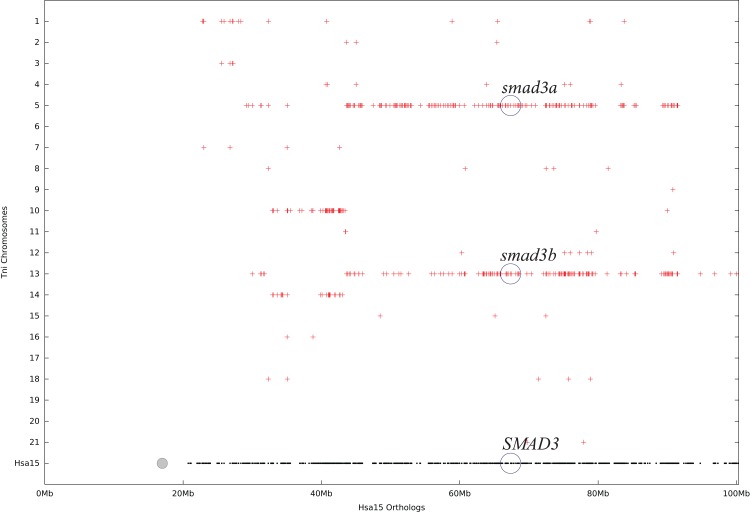
Chromosome synteny of teleost SMAD3 paralogs.The dot plot between human SMAD3 region and green spotted puffer genome indicates that human SMAD3 gene region in chromosome Hsa15 shares double conservation with green spotted puffer smad3a gene region in chromosome Tni5 and smad3b gene region in chromosome Tni13. The black dots represent segments in human chromosome Hsa15, and the red dots represent the conserved segments in green spotted puffer genome which mostly located in chromosome Tni5 and Tni13.